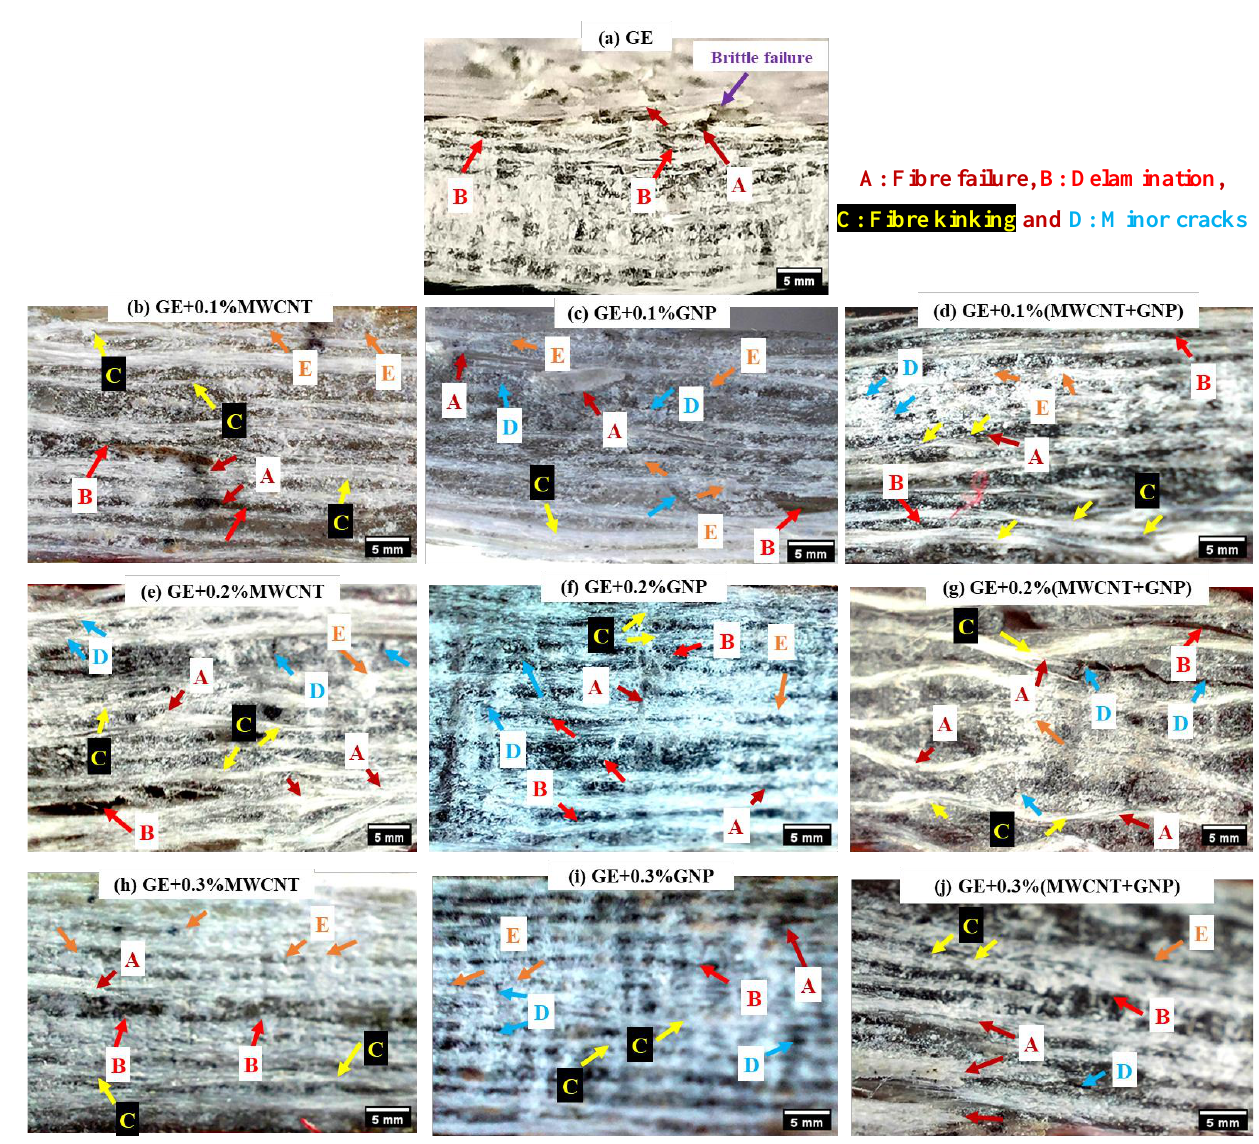
Figure 12. Flexural failure of GE and its nanocomposites (UD).